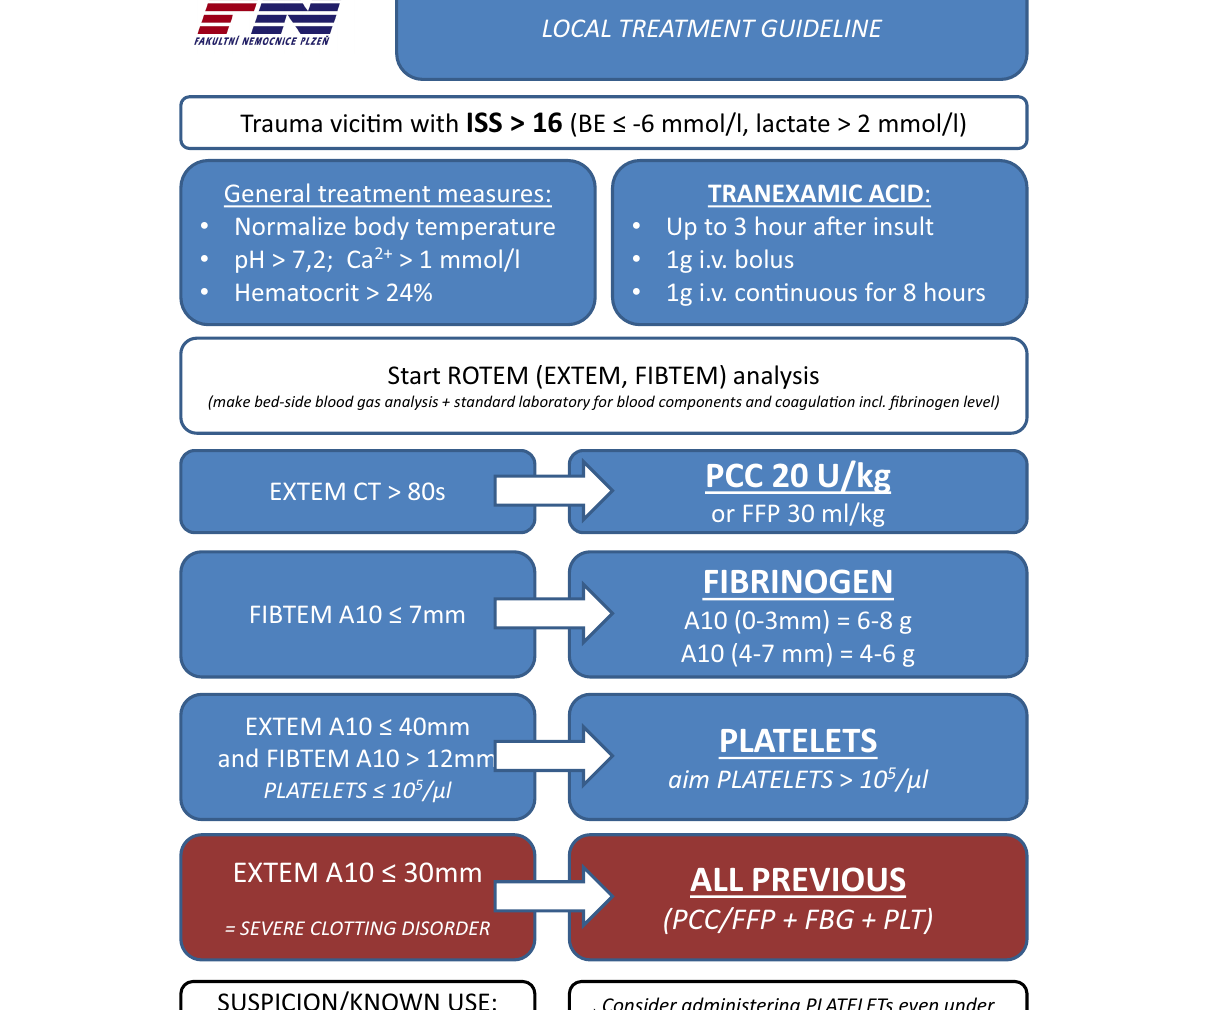
normo-, and hypercoagulable states. A hypercoagulable profile (G (cid:21) 11.7 dynes cm (cid:0) 2 ) was observed in 10% of trauma